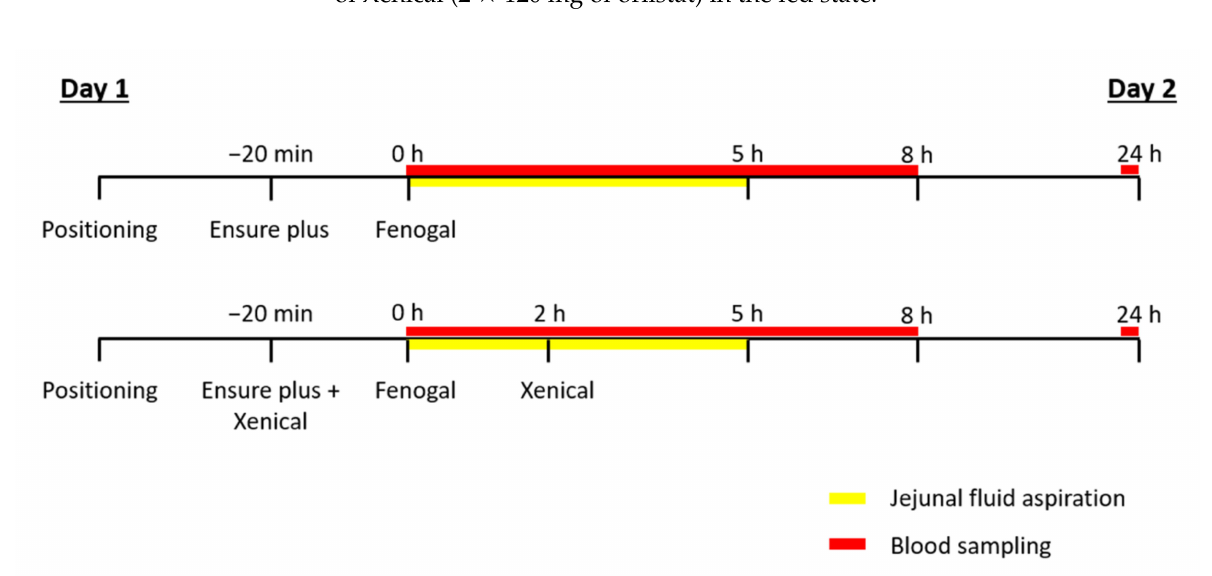
Figure 1. Schematic representation of the clinical study wherein Fenogal was administered in the fed state, with and without the administration of